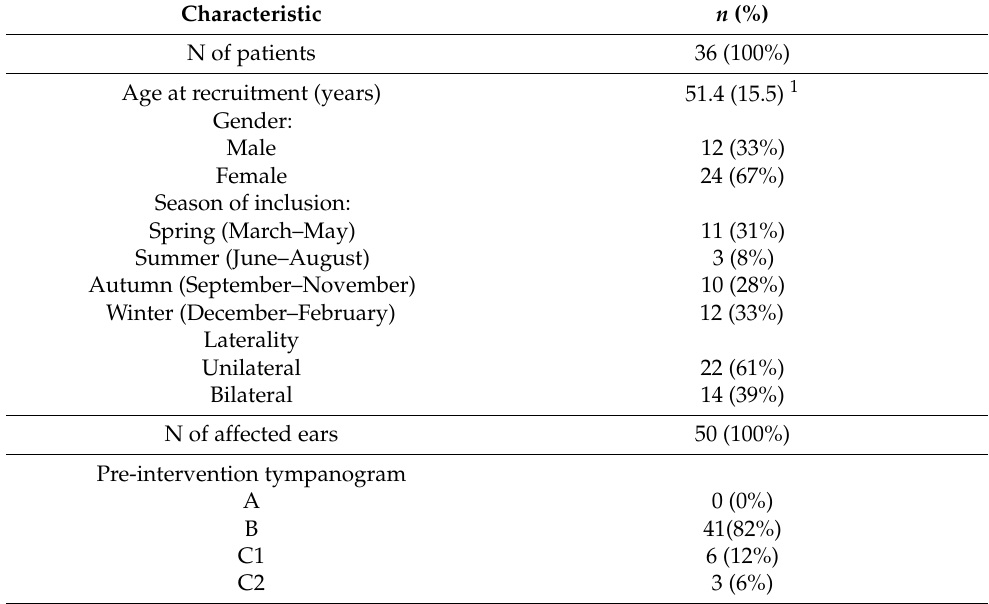
Table 1. Baseline characteristics of patients by treatment group. Characteristic n (%) N of patients 36 (100%) Age at recruitment (years) 51.4 (15.5) 1